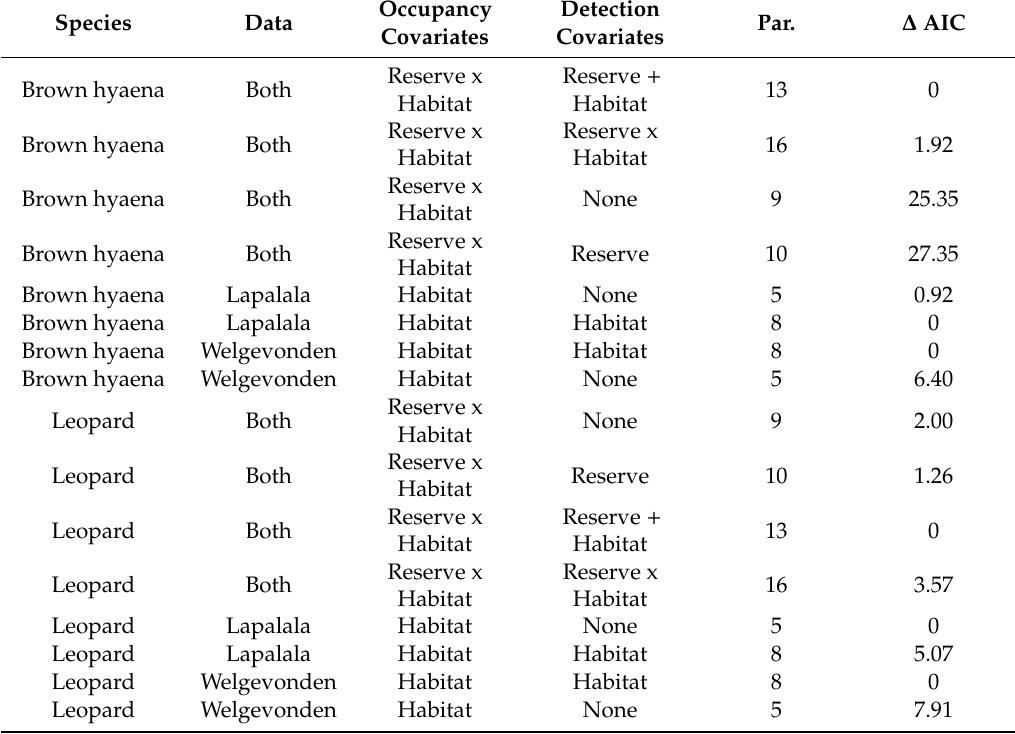
Table A3. Included data, occupancy and detection covariate structures, number of parameters as well as delta ( ∆ ) Akaike’s Information Criterion (AIC) values for several candidate occupancy models of brown hyaenas and leopards in Lapalala and Welgevonden. Models within 2 ∆ AIC units were regarded